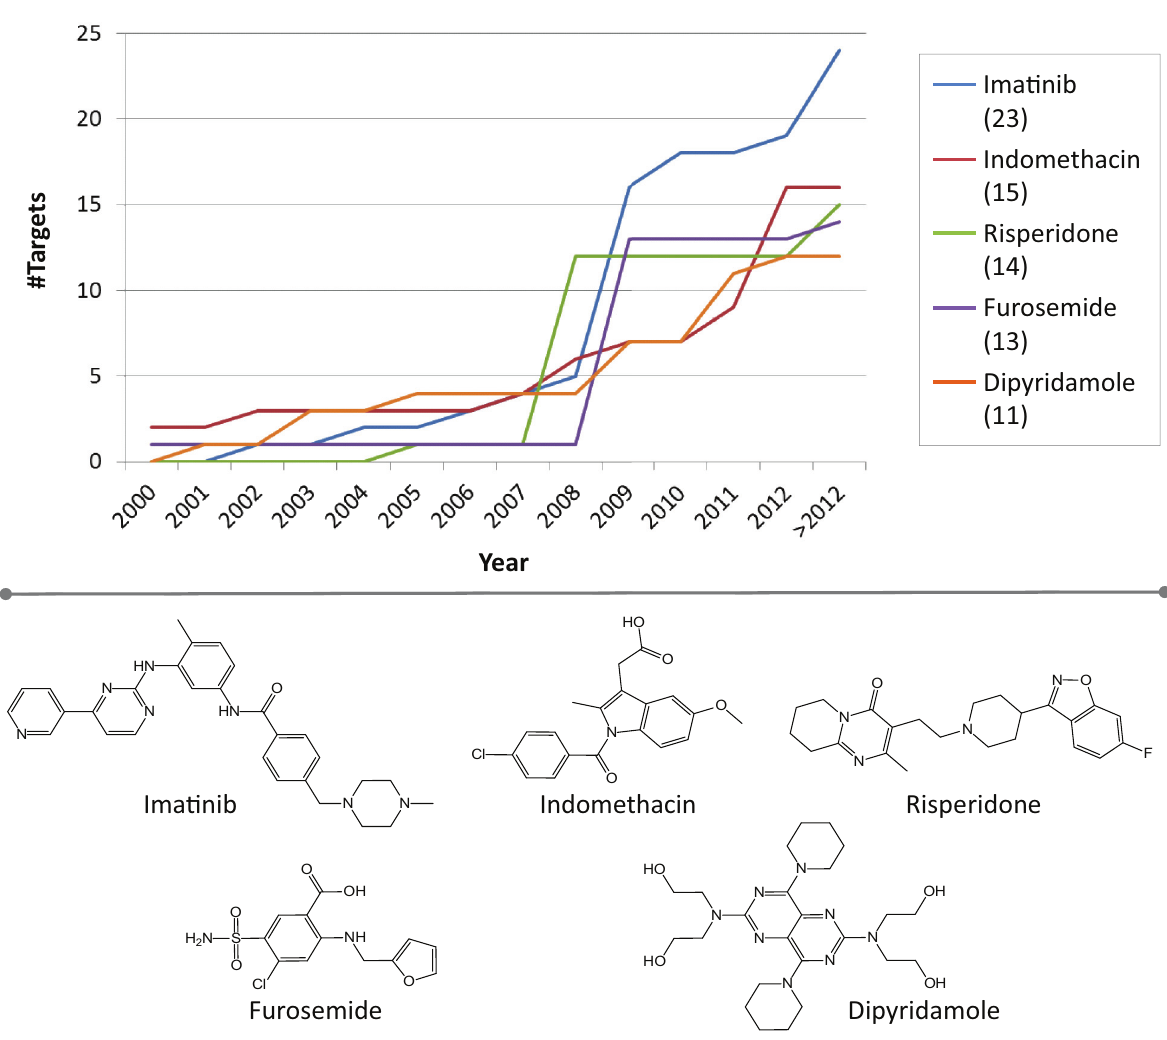
Figure 8. Top five drugs with largest changes in promiscuity. For the five drugs with largest changes in promiscuity over time, cumulative numbers of targets are reported for different years (top). For each drug, the overall difference in target annotations is given in parentheses. The structures of these drugs are shown at the